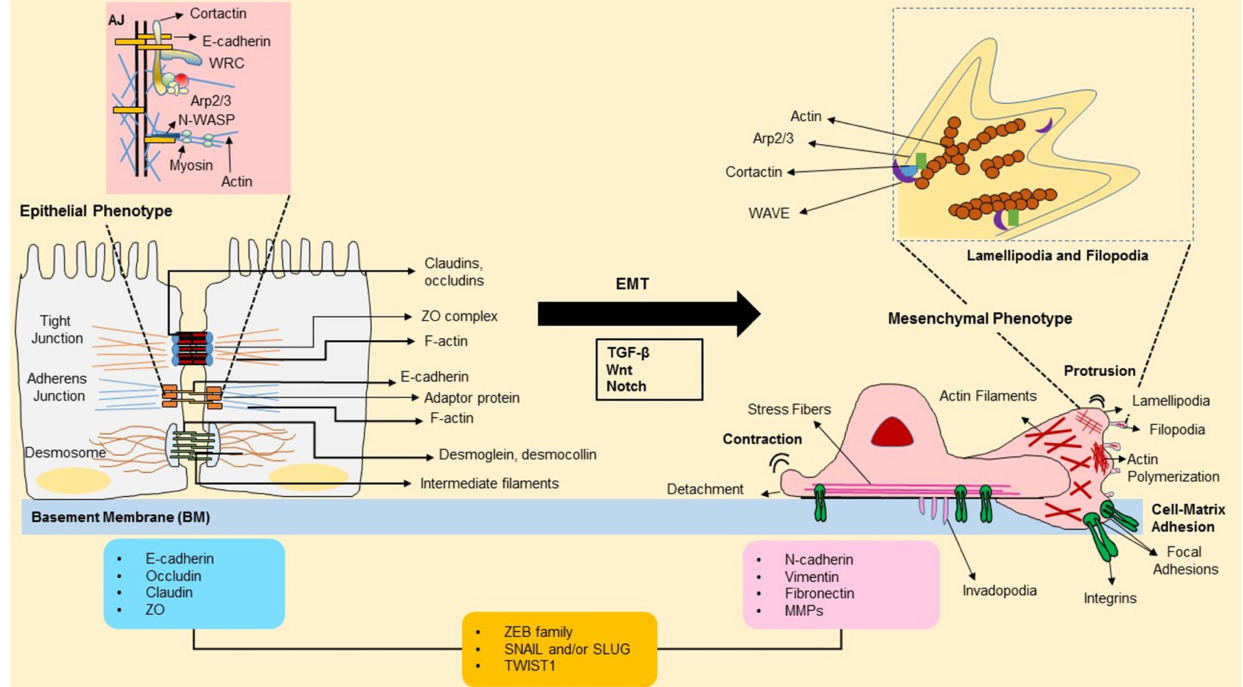
Figure 2. Layout of an epithelial-mesenchymal transition (EMT) transition process and forward migration of cells. Epithelial cells are bound together by tight junctions, adherens junctions, and desmosomes. The adherens junctions are cadherin-based and actin filament-associated cell-to-cell junctions that are composed of defined protein complexes. Epithelial cells are tightly secured to the basement membrane via highly specialized integrin-mediated attachment structures. Signaling pathways are said to trigger the EMT process—propagated by various EMT-TFs, such as ZEB, SNAIL, and TWIST that curb gene expression (listed in the blue box) related with the epithelial state and induce expression of genes associated with the mesenchymal state (listed in the pink box). Mesenchymal cells contain vimentin-based intermediate filaments and use integrin-containing focal adhesions to attach to the ECM. In contrast to epithelial cells, mesenchymal cell migration presents a leading and trailing edge and an extensively reorganized cytoskeleton. Lamellipodia is formed by polymerization of actin by the WAVE-Arp2/3 nucleation